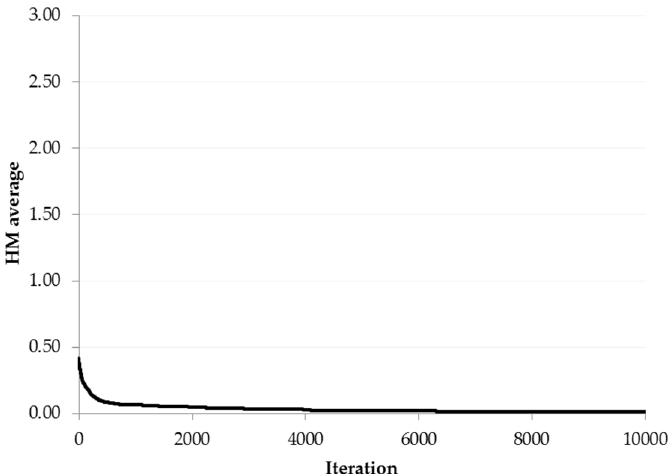
Figure 5. The performance of the harmonic memory (HM, 40 harmonies) with respect to iterations of the optimization function for EV1-3P of hydrometric station 10040.